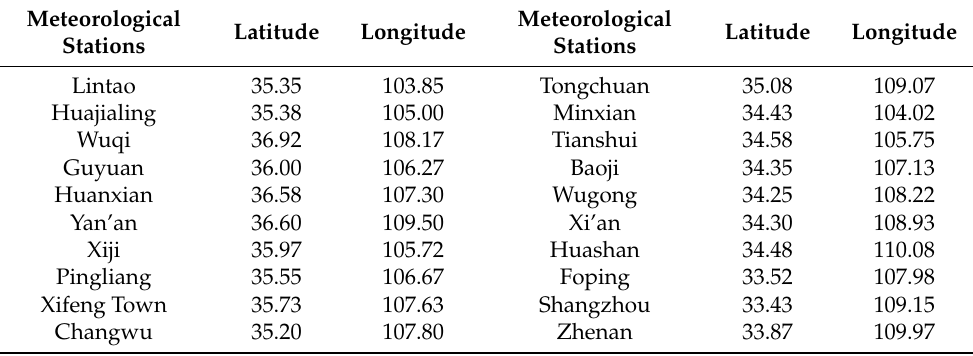
Table 1. 20 National Meteorological Stations in the Wei River Basin.